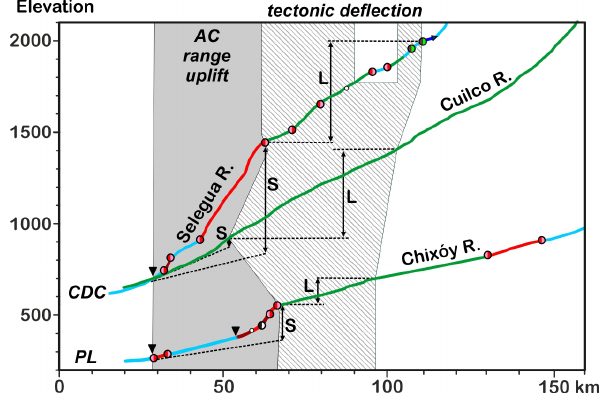
Figure 15. Long profiles of rivers transverse to the AC range (Chixóy, Selegua, and Cuilco), with indications of reaches affected by vertical rock uplift (grey area), and those affected by horizontal lengthening along the Polochic fault (hatched area). S and L rep- resent contributions of steepening and lengthening to the uplift of river profiles upstream of the AC range. River knickpoint nomen- clature is listed in Fig.